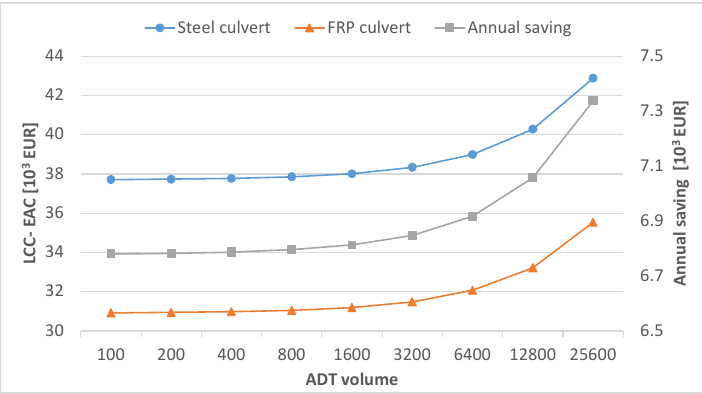
Figure 14. Impact of the ADT volume on the total LCC and annual saving.